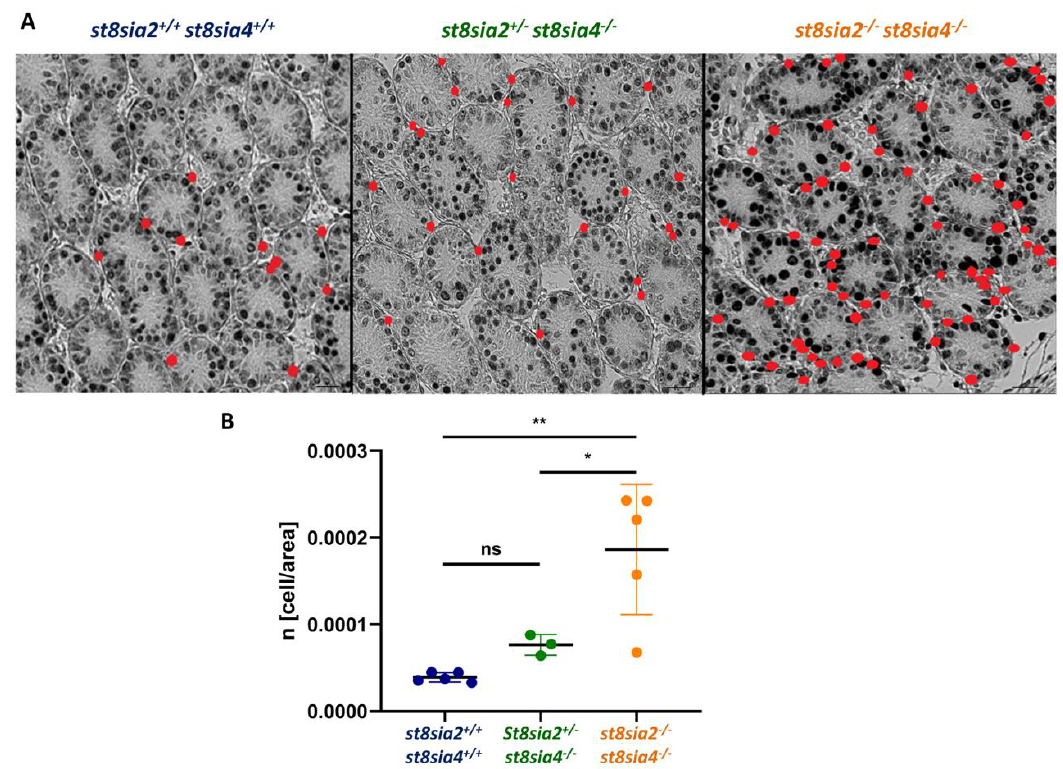
Figure 7. Investigation of proliferating peritubular cells in wild-type, st8sia2 +/− ; st8sia4 −/− mice, and polySia-negative mice. ( A ) For the immunohistochemical visualization of proliferating peritubular cells, testicular sections of postnatal wild-type ( st8sia2 +/+ ; st8sia4 +/+ ), st8sia2 +/− ; st8sia4 −/− , and polysialyltransferase-deficient ( st8sia2 −/− ; st8sia4 −/− ) mice were treated with a mAb against PCNA. The positive cells were labeled with red dots. Supplemental Figure 3 shows the same sections with smaller dots, which allow an additional evaluation of the peritubular cell-specific morphology. ( B ) Based on the immunohistochemical labeling of proliferating peritubular cells, the density of positive cells in the seminiferous tubules was calculated. The values (5 wild-type, 3 st8sia2 +/− ; st8sia4 −/− and 5 double knockout animals; per animal 3 sections were analyzed) are summarized and standard deviation (SD) is displayed in addition to the means. Statistically significant differences are indicated: * p < 0.05; ** p < 0.01, ns: not significant. The PCNA-positive cells within the tubules were not considered in the study.